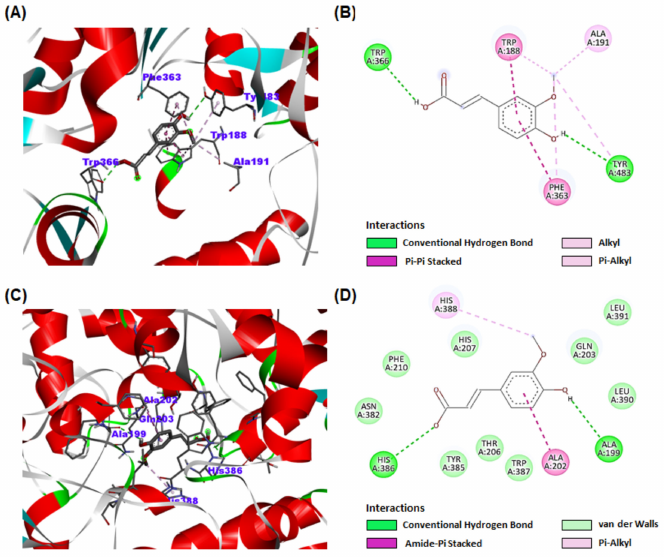
Figure 9. Molecular docking simulations of compound 1 binding to iNOS and COX-2 proteins. ( A , C ) Three-dimensional modeling of compound 1 binding within iNOS and COX-2 proteins. ( B , D ) Two-dimensional ligand interaction between compound 1 and iNOS and COX-2